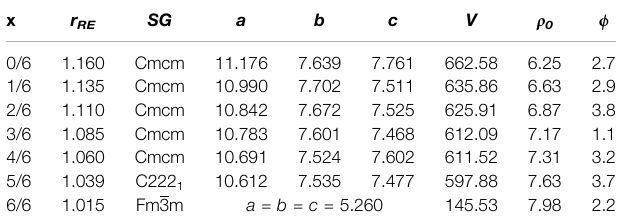
TABLE 1 | The effective RE 3+ size (rRE/Å), space group (SG), lattice constants (a,b,c/Å),unitcellvolume(V/Å 3 ),theoreticaldensity( ρ 0 /g · cm − 3 ),andporosity ( ϕ /%) of (La1-xHox) 3 NbO 7 ( x (cid:2) 0/6, 1/6, 2/6, 3/6, 4/6, 5/6, and 6/6)